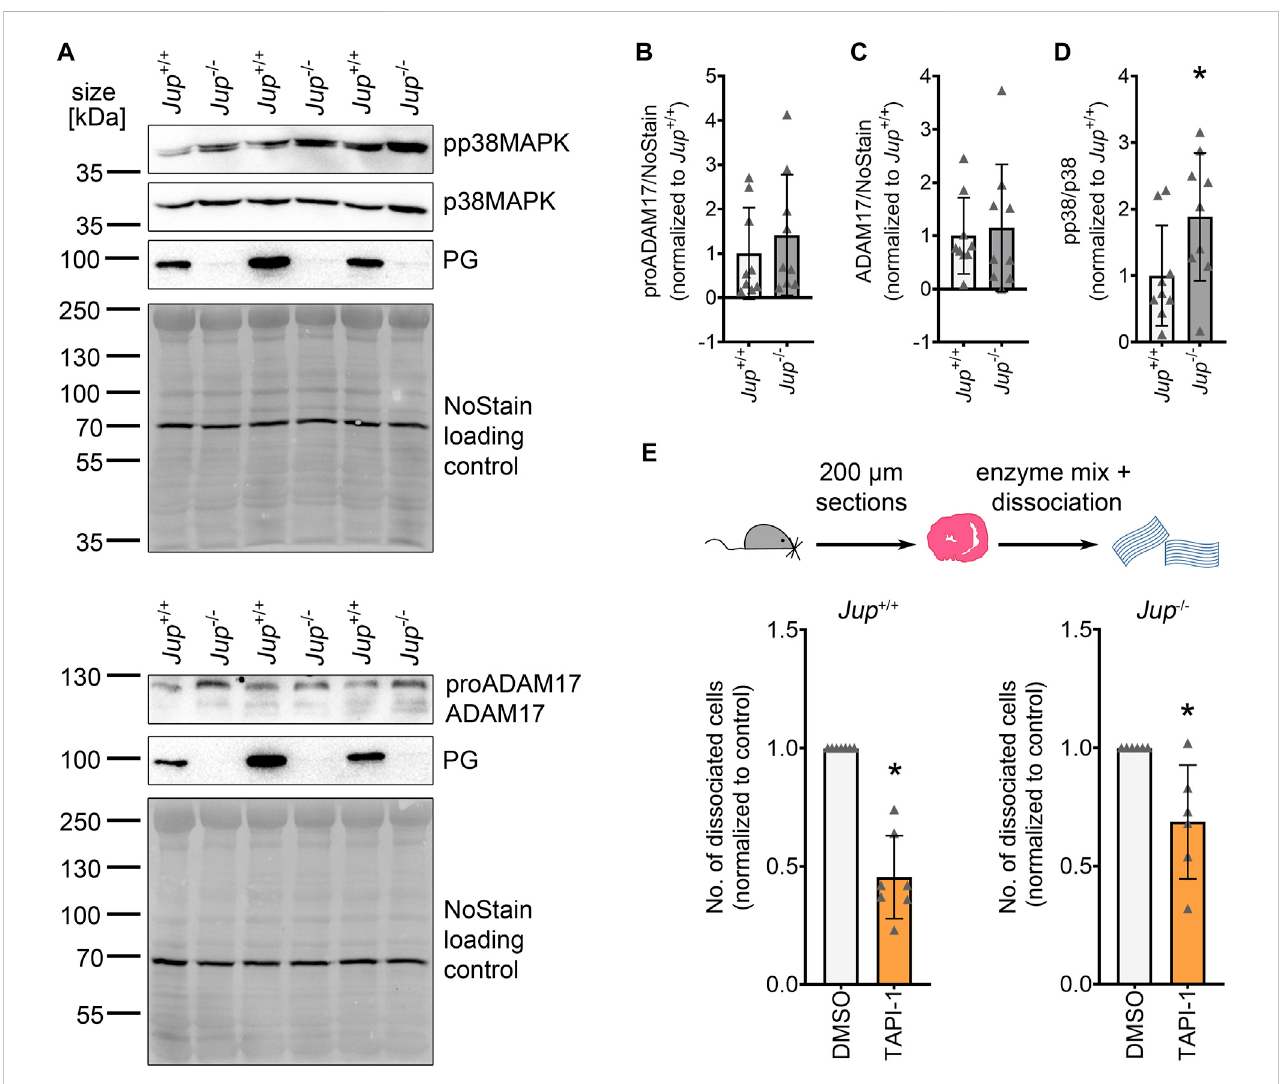
FIGURE 1 ADAM17 inhibition leads to positive adhesiotropy in Jup +/+ and Jup − / − mice. (A) Representative Western blot showing protein expression of pp38MAPK, p38MAPK, ADAM17 and PG in Jup +/+ and Jup − / − mice. NoStain Dye ™ was used as loading control. (B – D) : Quanti fi cation of protein expression assessed by Western blots shown in (A) . (B) proADAM17 protein expression. (C) ADAM17 protein expression. (D) phosphorylation of p38MAPK. * p ≤ 0.05, unpaired Student ’ s t -test, N =9mice. (E) Dispase-baseddissociationassayinmurinecardiacsliceculturesobtainedfrom Jup +/+ and Jup − / − miceuponinhibitionof ADAM17 by TAPI-1. * p ≤ 0.05, unpaired Student ’ s t -test, N = 7 for Jup +/+ and N = 6 for Jup − / −